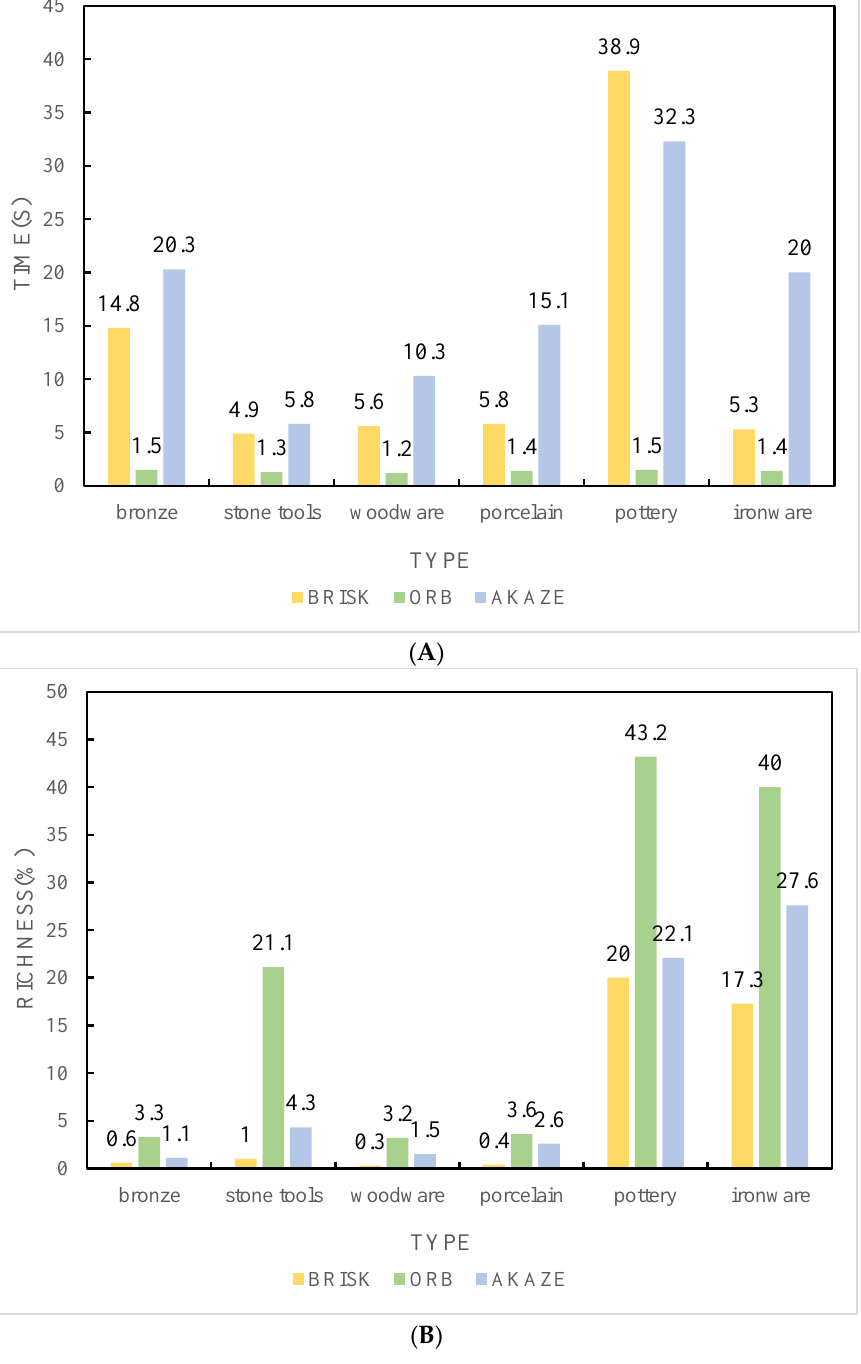
Figure 2. Comparison of the computing performance of the three algorithms. ( A ) Computational time comparison. ( B ) Feature richness comparison.